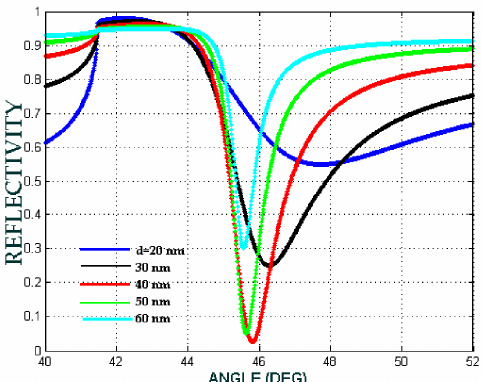
Figure 7. The attenuated total reflection (ATR) spectra for Ag metal thicknesses varying from 20 nm to 60 nm with the SPR biosensor configuration prism/Ag/Fe 3 O 4 @Au + biomaterial sample/air at a = 2.5 nm, the biomaterial sample is Hb cytoplasm with RI 1.3800 and F = 0.1.